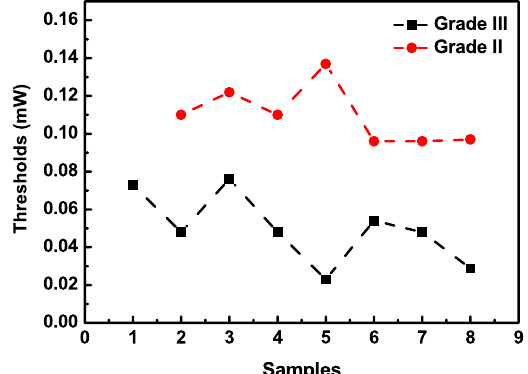
Figure 6. The thresholds of nanotextured DCJTB embedded in malignant tissues from 15 randomly selected